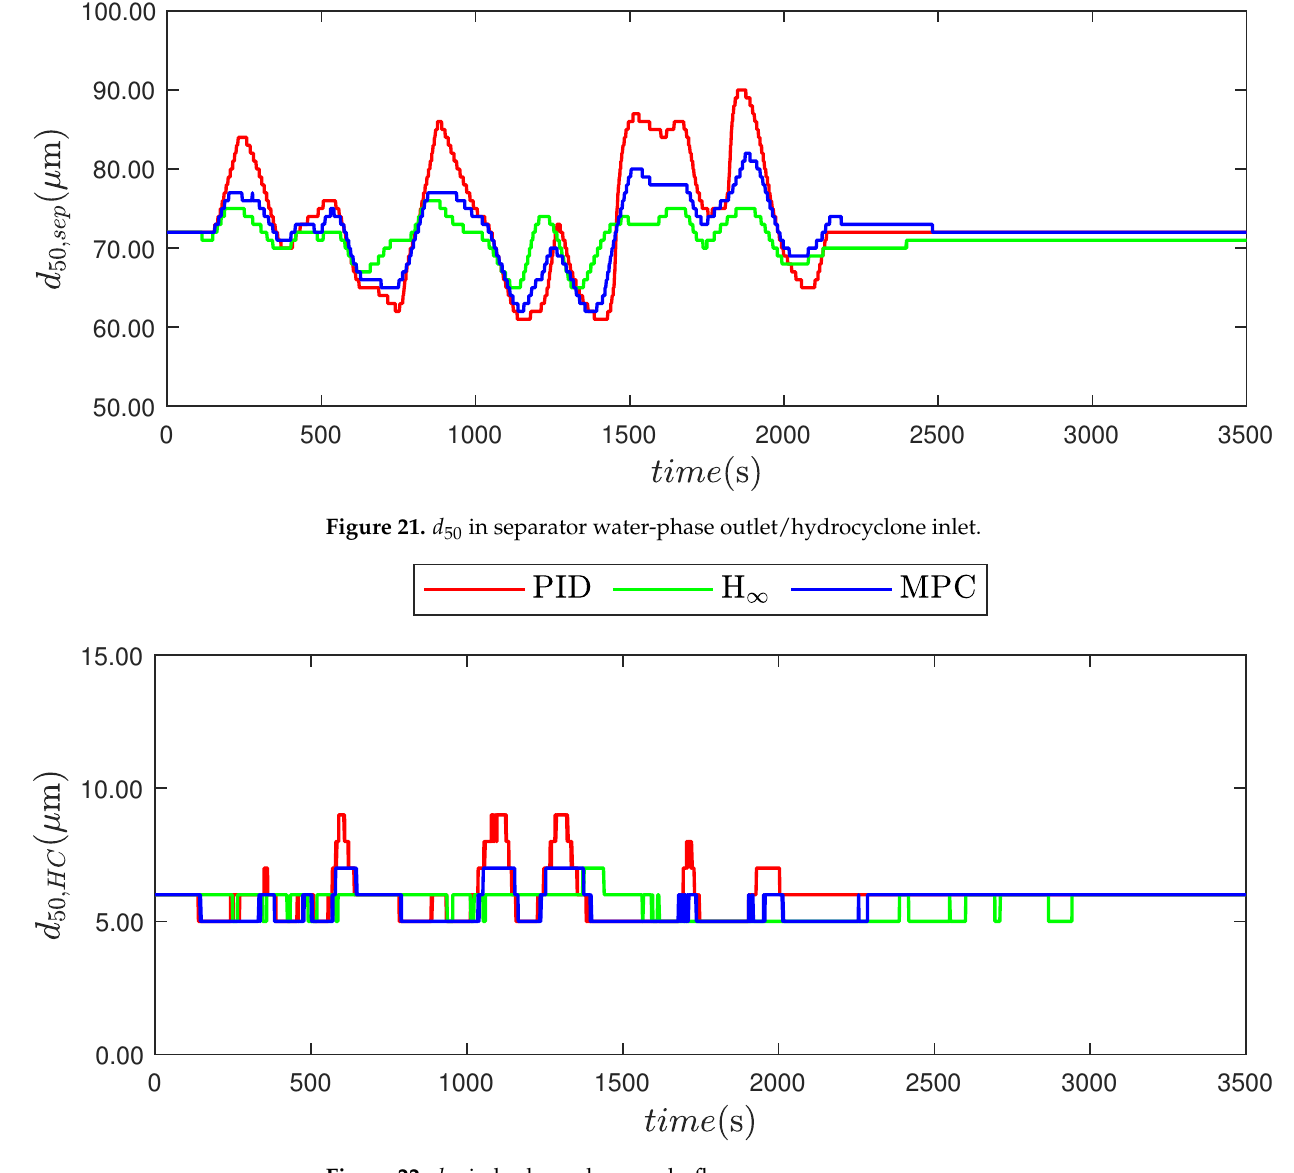
Figure 22. d 50 in hydrocyclone